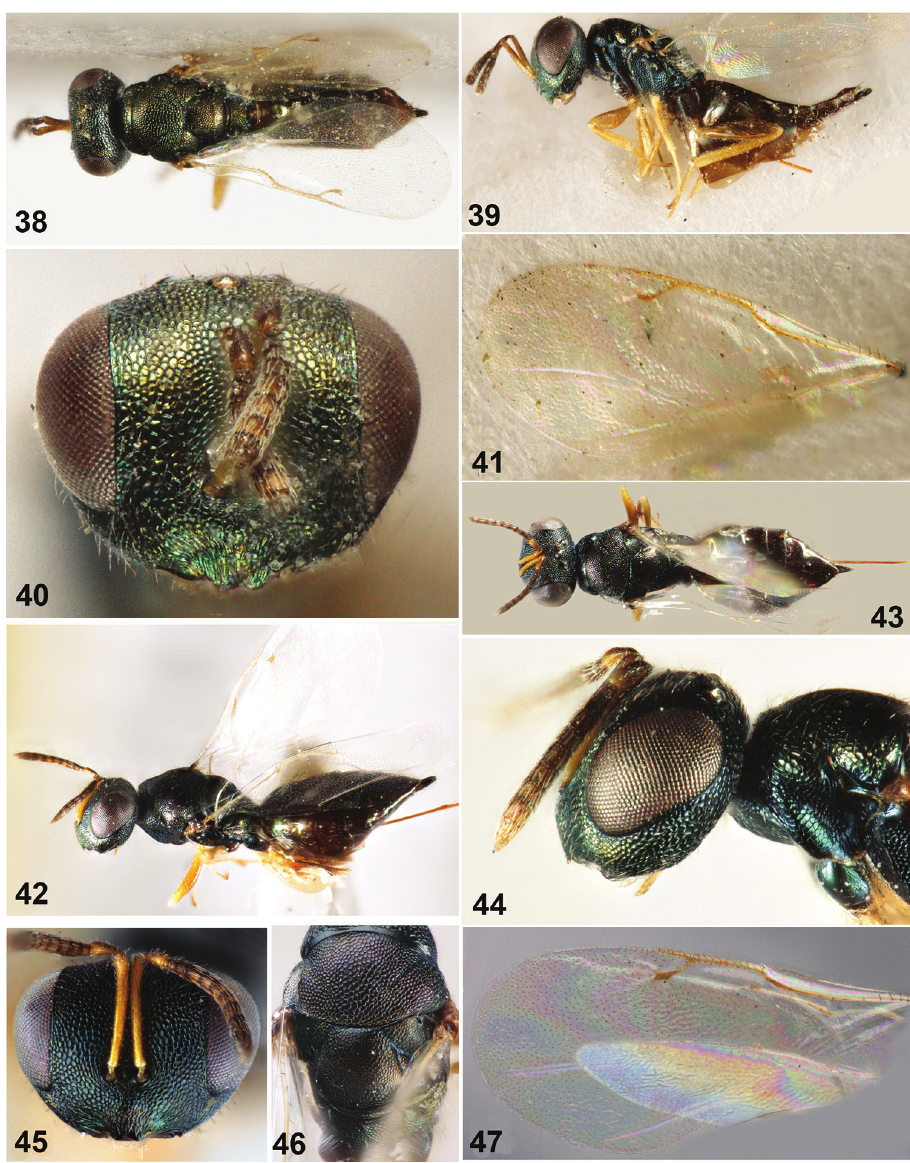
Figures 38–47. 38–41 Dibrachys microgastri (Bouché) 38 Body in dorsal view 39 Body in lateral view 40 Head in frontal view 41 Fore wing 42–47 Dibrachys qinghaiensis sp. n., female holotype 42 Body in lateral view 43 Body in dorsal view 44 Head in lateral view 45 Head in frontal view 46 Mesoscutum 47 Fore